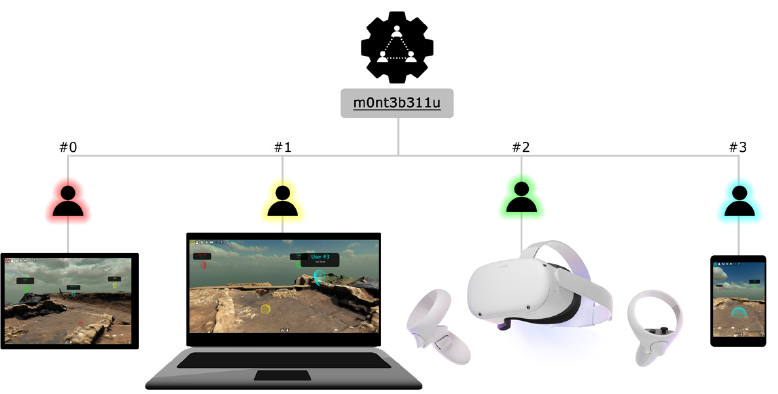
Figure 13. A collaborative session with ID “m0nt3b311u” involving multiple remote users, with different